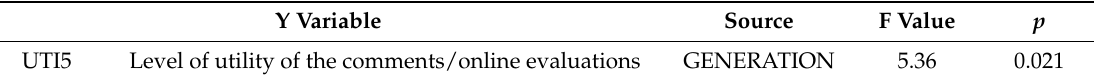
Table 4. Model with UTI5 “Level of utility of the comments/online evaluations”.